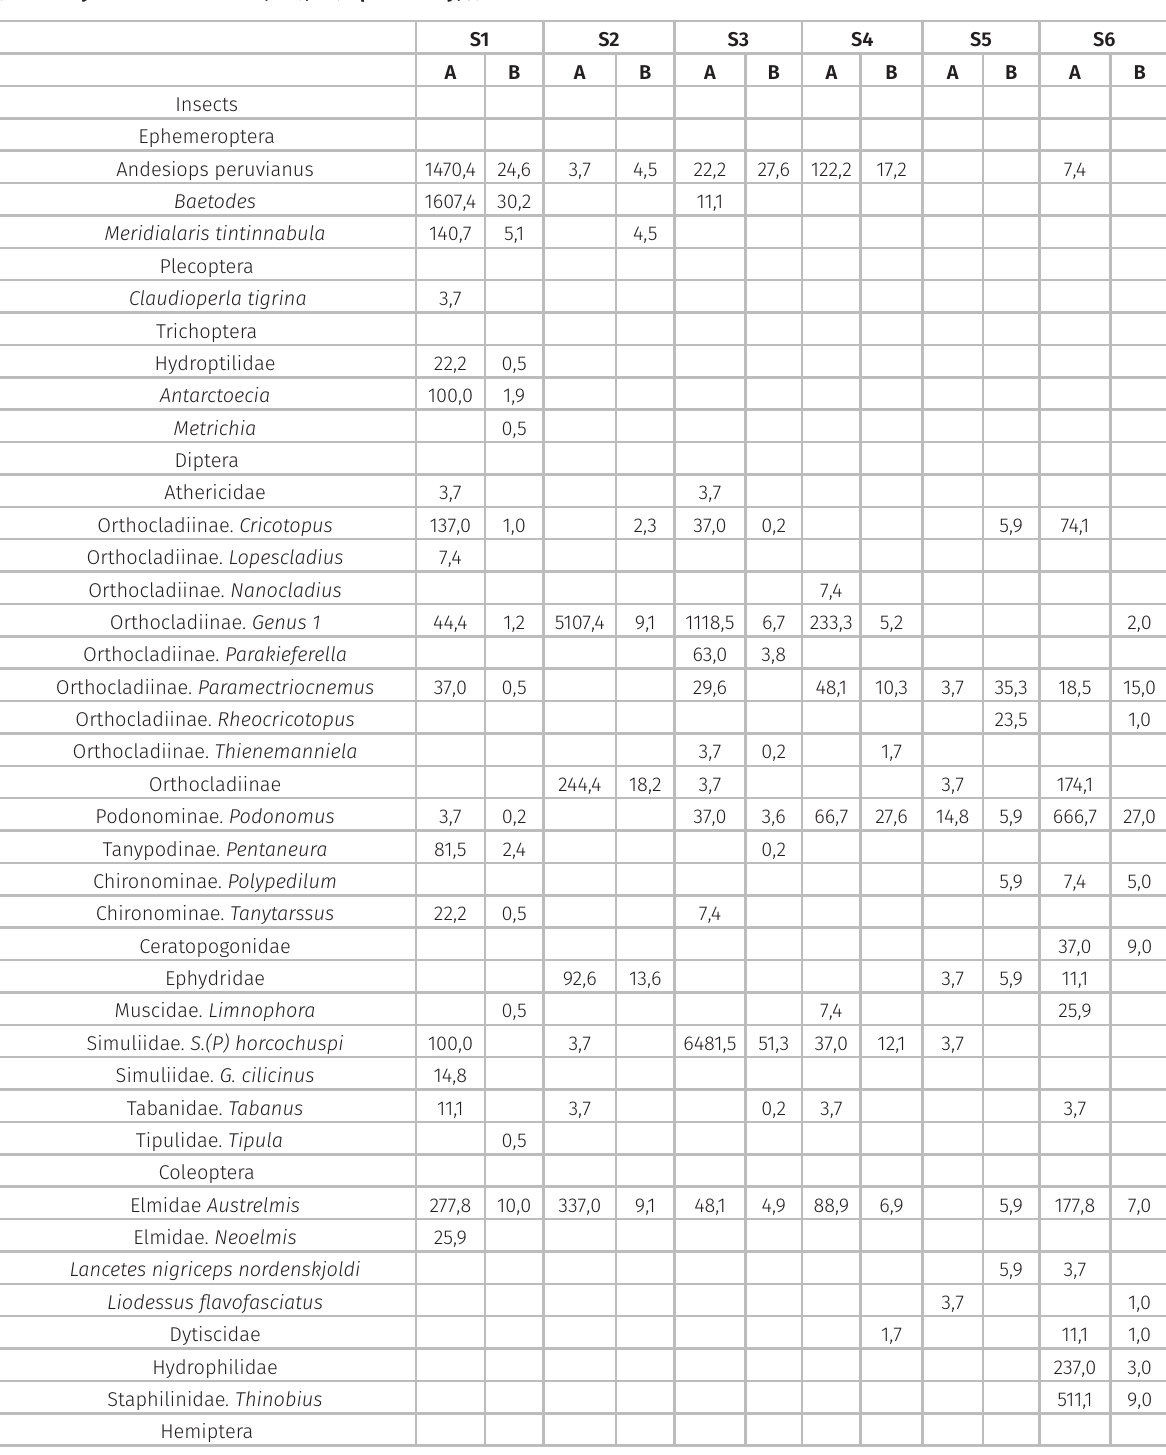
Table IV. Benthic invertebrates in Rosario basin (Salar de Olaroz, Jujuy, Argentina). A: abundance (ind/m2 ) from quantitative method; B: taxon specific abundances in percentage (%) from qualitative method. S1- S4 were placed at Rosario river; S5: Sierra de Tanques stream; S6: Toro river. N (total abundance, ind/m2 ); R (richness), D (diversity Shannon Wiener, H´); E (Equitability,